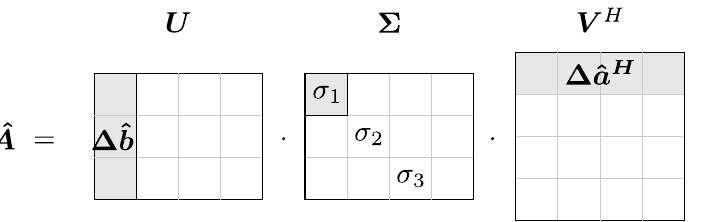
Figure 5. Steering vector offsets extracted from SVD decomposition of the initial estimate of channel matrix offsets.